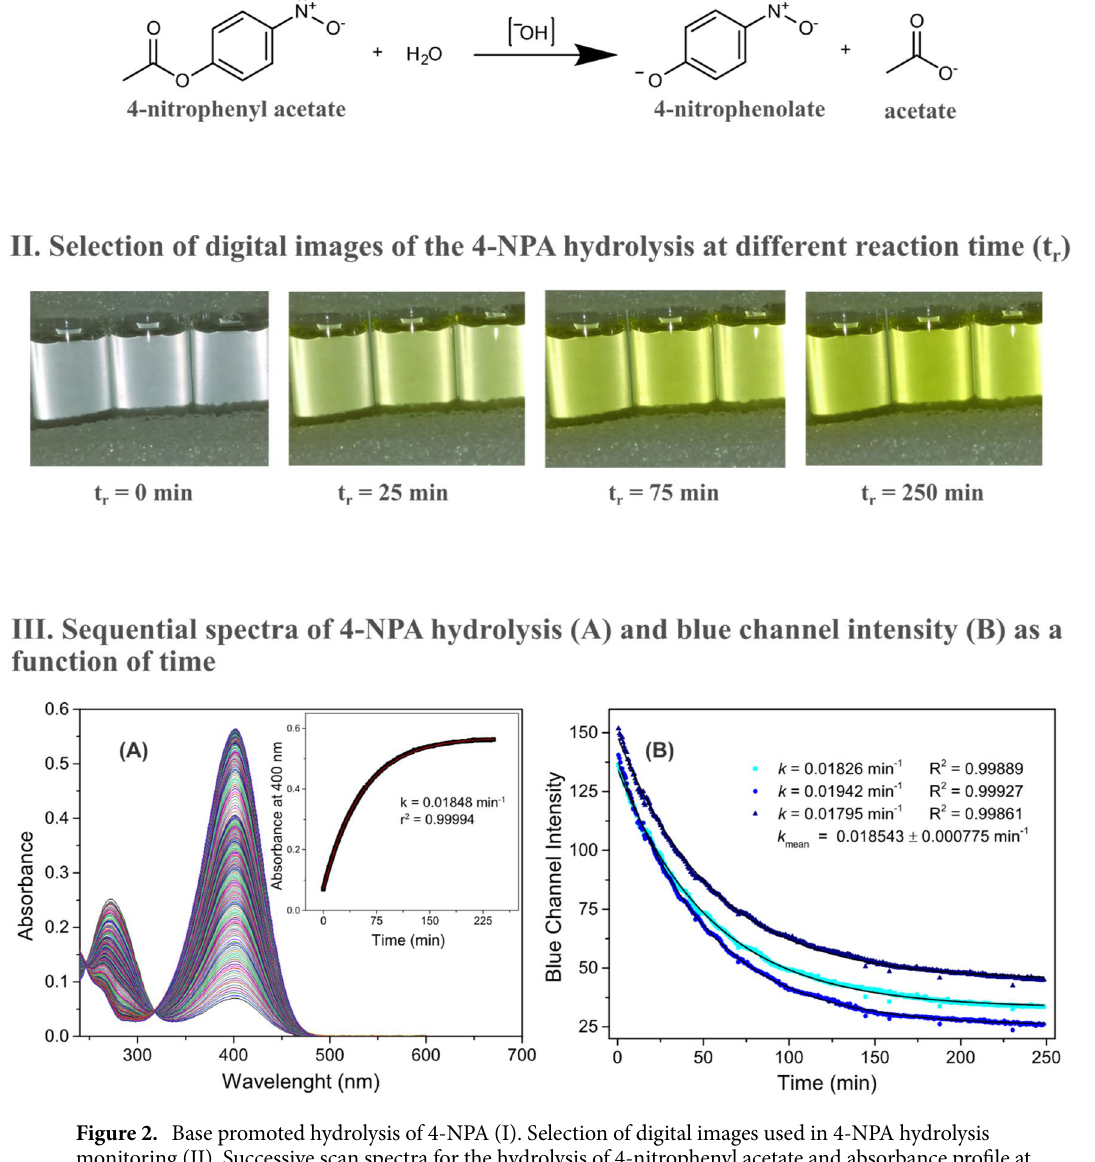
colorless medium (aqueous basic solution) placed in front of a white background turns yellowish by the addition or formation, in the case of 4-NPA hydrolysis, of 4-NP. Ideally, before 4-NP is present the photo acquired from the solution would be pure white, i.e., when no dye is present it is expected that RGB values are all 255. As 4-NP is added the color detected should become yellowish. For pure yellow R = 255, G = 255 and B = 0. However, the actual color acquired in the initial system is grayish, with lower RGB values than white, and the yellowish final solution has lower RG and higher B values than pure yellow. This can be a result of the non-ideal illumination system employed. Besides, no electronic color correction was employed. However, even with possible deviations from the color acquired the data of Fig. S1 show that the R and G components are basically constants as the dye concentration increases, and, more importantly, the B channel is linearly proportional with the 4-NP concentra- tion. Therefore, there is no need for any type of image manipulation or color calibration. It is important to note that changes in the geometric arrangement slightly affect the slope of the intensity versus concentration profile. For instance, varying the distance between the camera and the reaction flask leads to different fitting parameters. However, the linear correlation between the dye concentration and the Blue channel remained (Fig. S2).